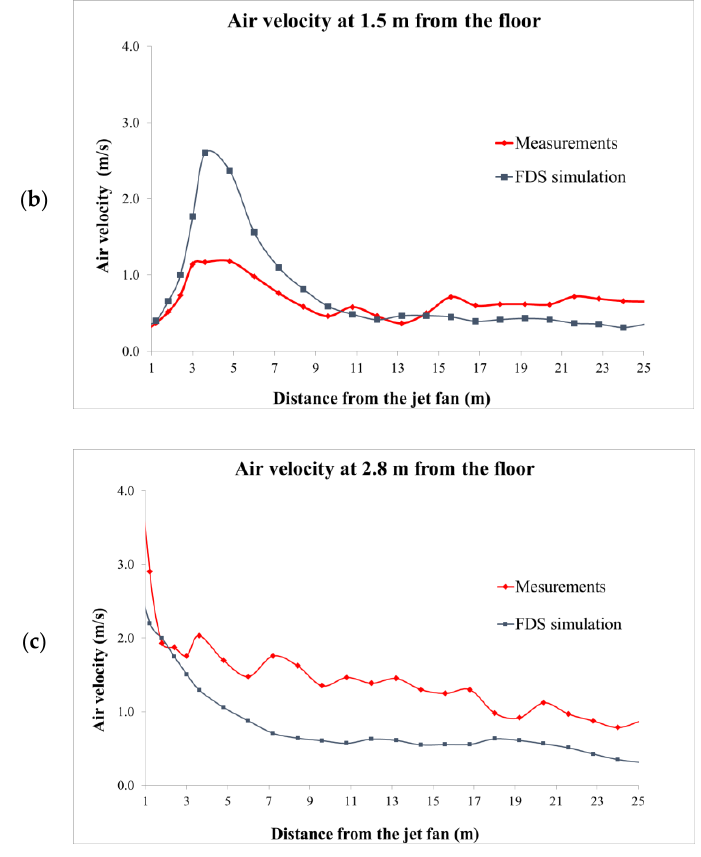
Figure 5. Results of the jet fan airflow velocity measurements and FDS simulations at heights from the floor of ( a ) 0.3 m; ( b ) 1.5 m; and ( c ) 2.8